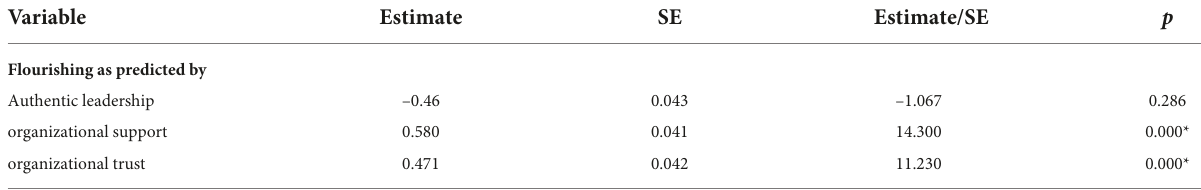
TABLE 3 Standardized regression coefficients of authentic leadership, organizational support, and organizational trust, in predicting employee